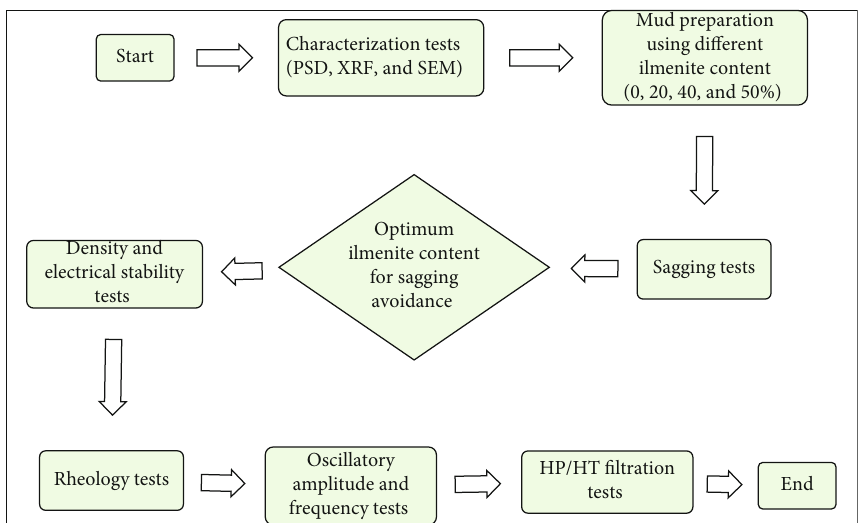
Figure 1: Experimental work fl